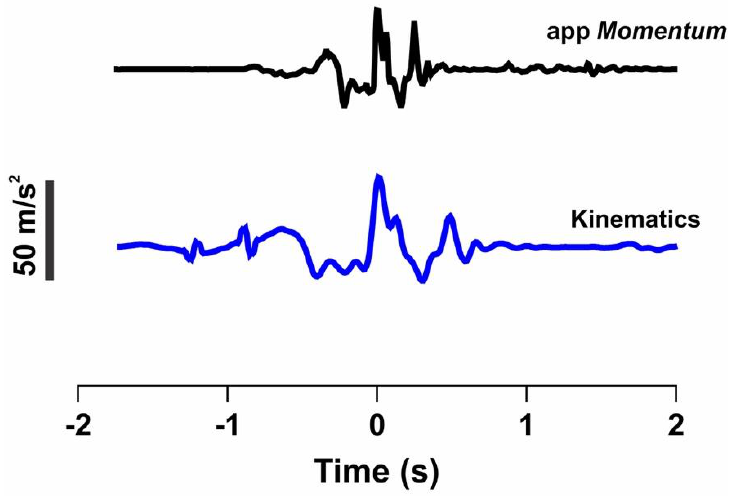
Figure 2. Vertical acceleration signals registered by Momentum app (black line) and by kinematics (blue line) during vertical jump. Dotted line represents peak acceleration on this axis, corresponding to impact with ground, which is used for synchronization. Acc: Acceleration.